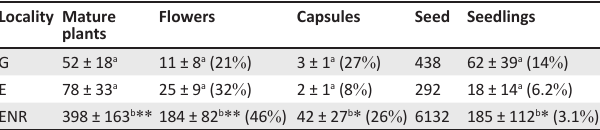
G, FIGURE 10: Pollination system of translocated Frithia humilis populations (G; E) in relation to a control population (ENR). Goedvertrouwdt Farm; E, Eagle’s Rock Private Estate; ENR, Ezemvelo Nature Reserve. TABLE 3: Mean number of mature plants, flowers, fruit, seed and seedlings per 1 m 2 for receptor sites and the control, as well as the flowering, fruiting and seeding percentage in